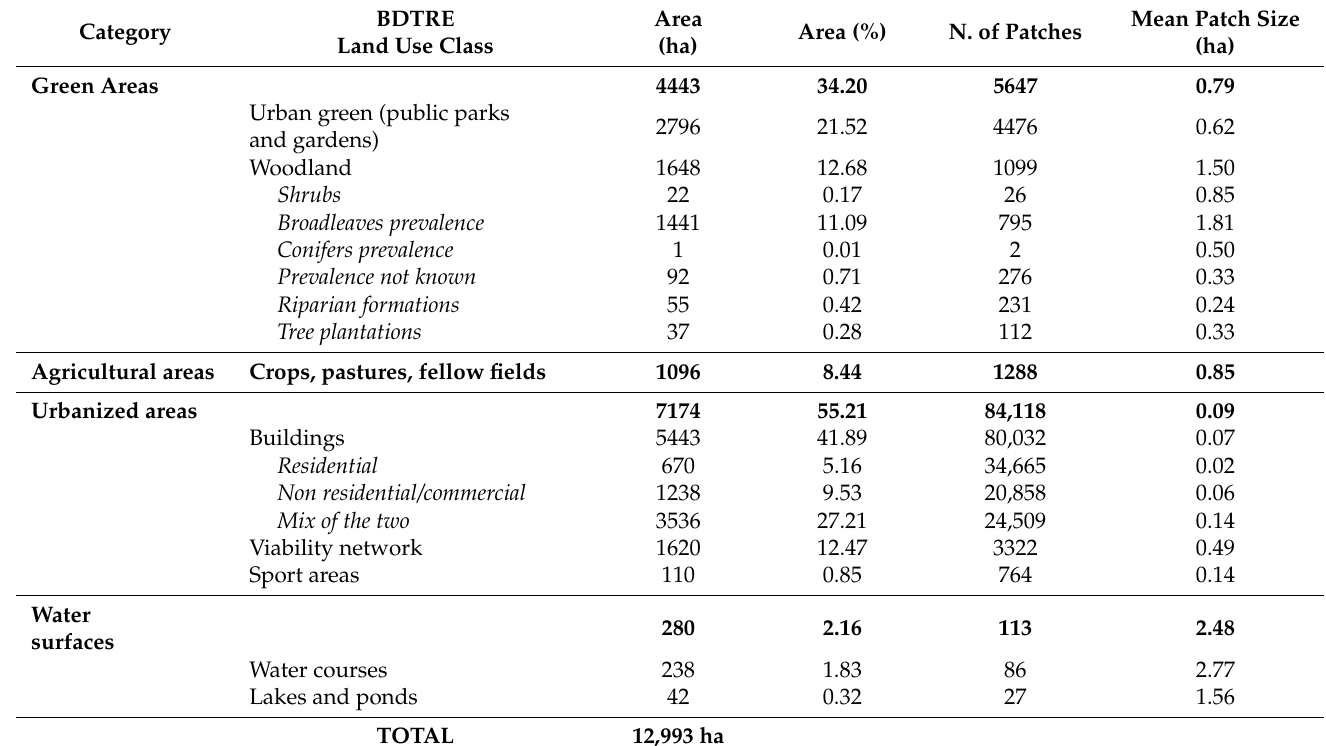
Table 1. Main land use classes as mapped in BDTRE in the municipality of